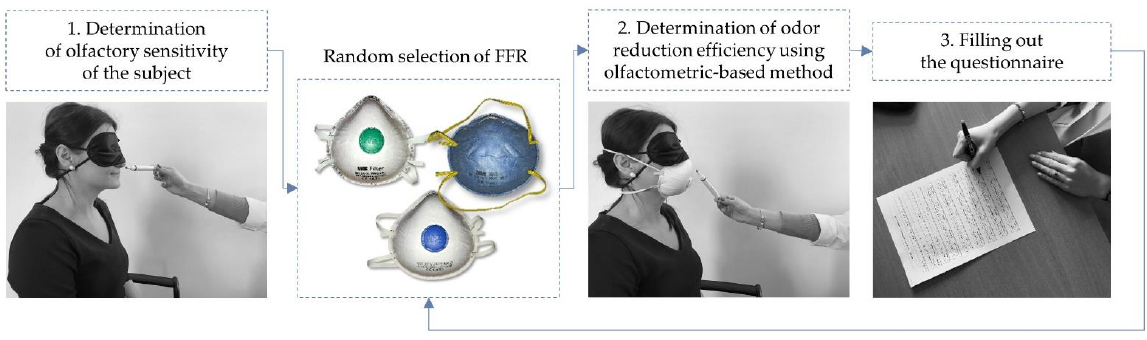
Figure 2. FFR evaluation